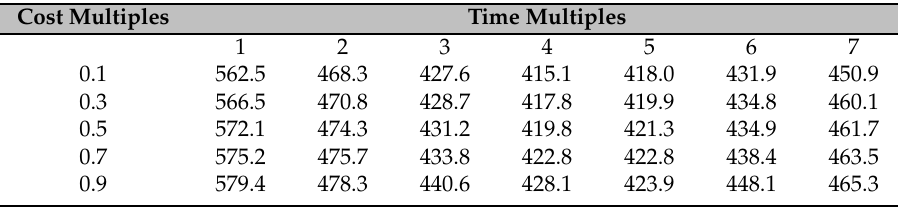
Table 6. Total integrated costs for the large test instance set in